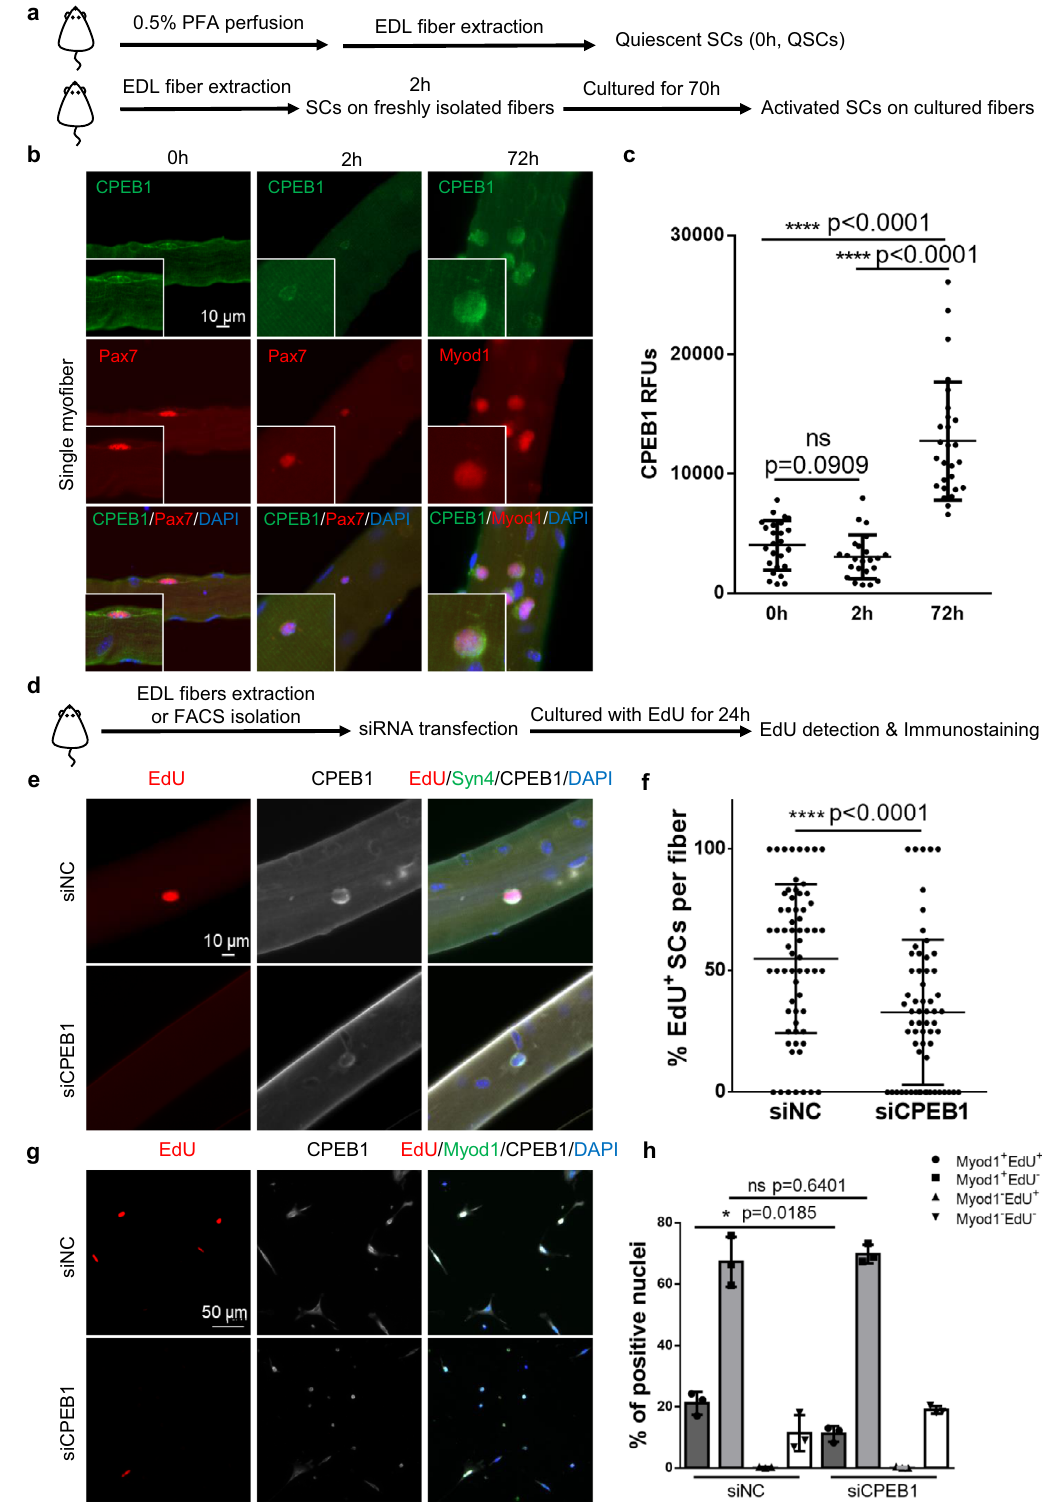
biogenesis, RNA transport, and TCA-cycle-related pathways (Fig. 3e). Regarding spliceosome-associated pathways, transcripts of genes involved in pre-mRNA splicing such as Dhx, Rbm, and Snrp gene families are bound by CPEB1 (Fig. 3f). In addition, for the energy metabolic pathways, genes encoding proteins involved in oxidative phosphorylation or TCA cycle identi fi ed as CPEB1 targets include Cox5a, Ndufa11, Uqcr10, Mdh1, and